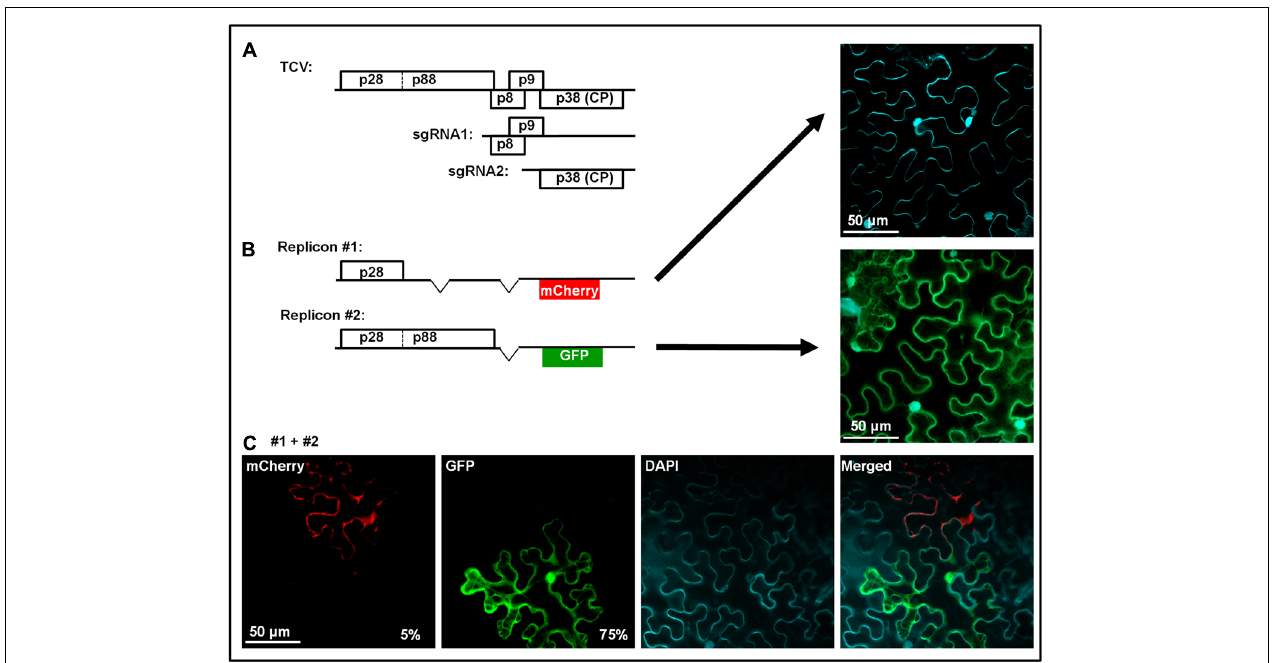
FIGURE 1 | Genome organization of TCV, and dominant SIE exerted by p28. This figure contains previously published data from our lab (Zhang et al., 2017). (A) Schematic representation of TCV genomic and subgenomic RNAs, and the proteins encoded. (B) Two mutant TCV replicons used in co-infections in (C) . Replicon #1 contains deletions within p88 and p8/p9 coding regions, and replacement of p38 by mCherry, thus cannot replicate on its own (top right image, cell boundaries visualized via DAPI staining). Replicon #2 encodes both p28 and p88, and GFP in place of p38, thus replicates in most of treated cells to produce green fluorescence (middle right image). (C) Cells co-infected by replicons #1 and 2. Rescue of replicon #1 in a fraction of cells led to mCherry but not GFP fluorescence, indicating that p28 expressed from the replicating #1 blocks #2, even though the former had to rely on p88 provided by the latter. Note that the constructs were provided in the form of cDNA, thus replicon #2 could be transcribed and translated to provide p88 independent of